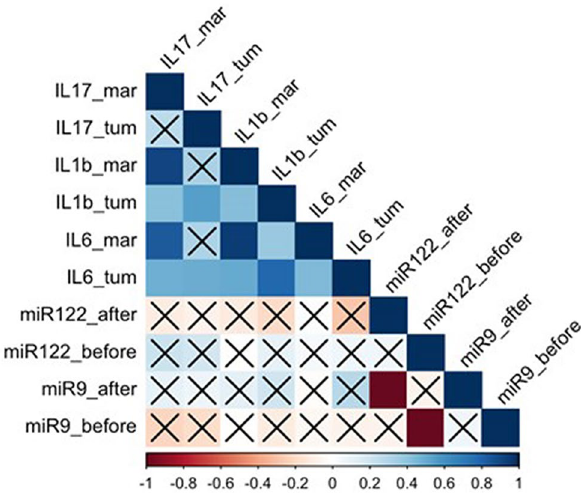
Figure 2. A Spearman’s rank correlogram. Correlations marked with X are not statistically significant (p > 0.05). The colour scale represents Spearman’s correlation coefficient (r). Legend: tum tumour sample; mar surgical